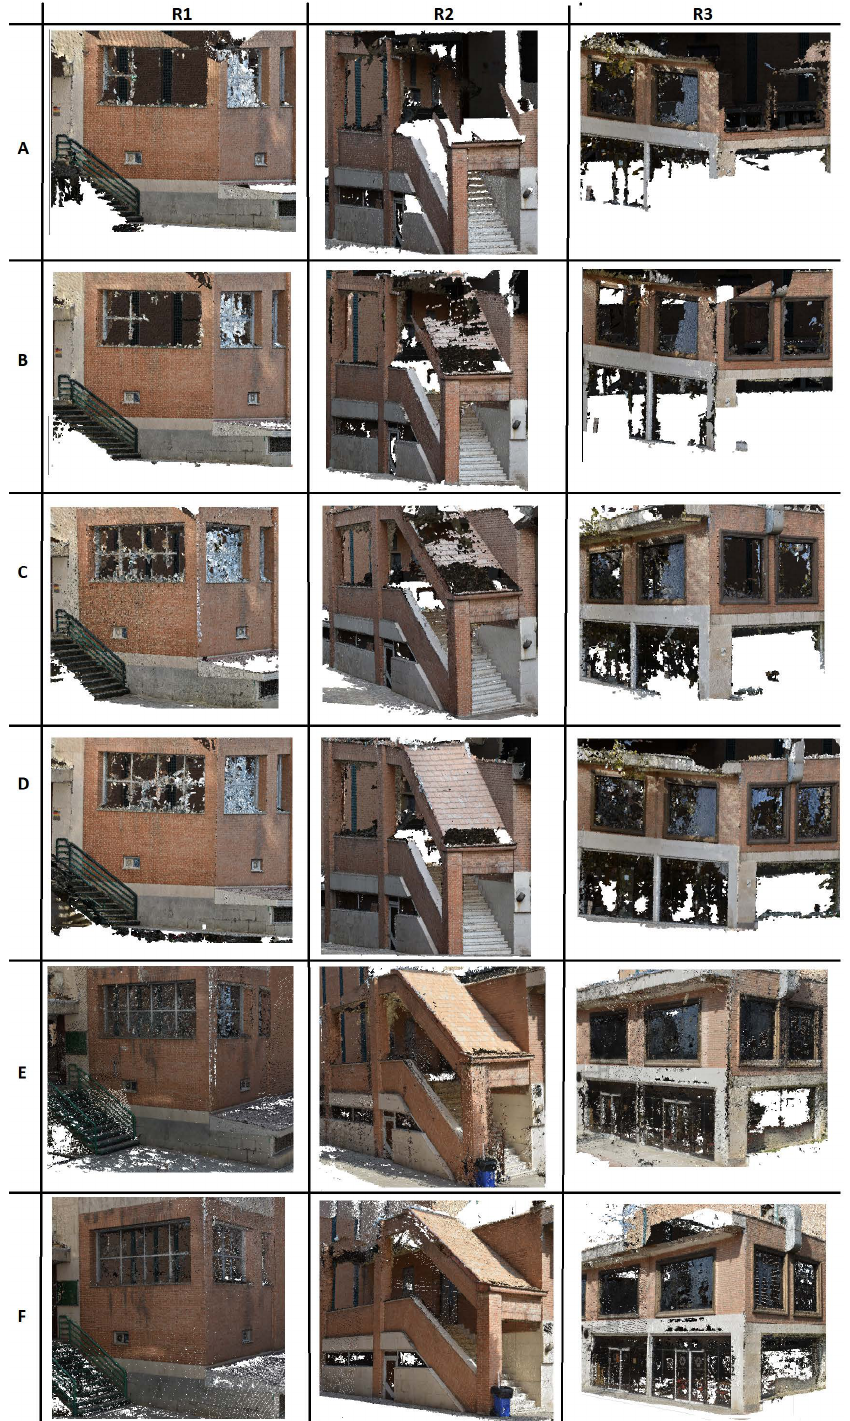
Figure 25. The dense point clouds generated with centre pointing ( A ), façade pointing ( B ), hybrid ( C ), centre & façade pointing ( D ), continuous image capturing ( E ), and continuous image capturing & clustering and selection ( F )